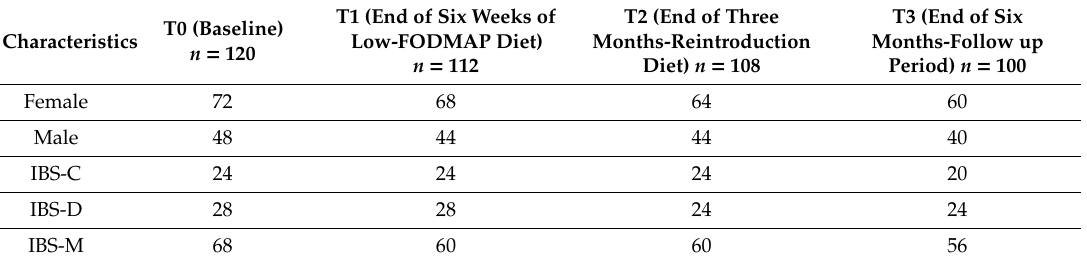
Table 2. Characteristics of the enrolled patients.